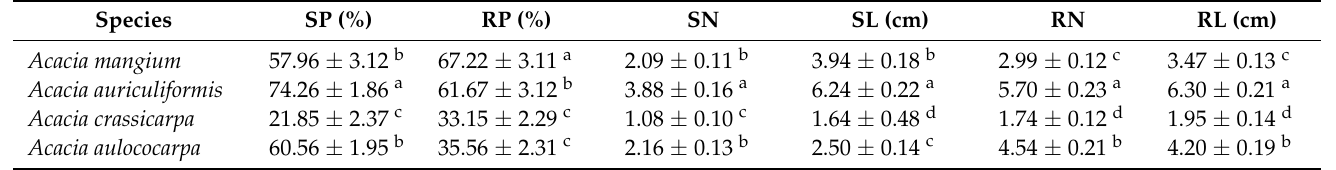
Table 4. Mean values for rooting ability of four Acacia species